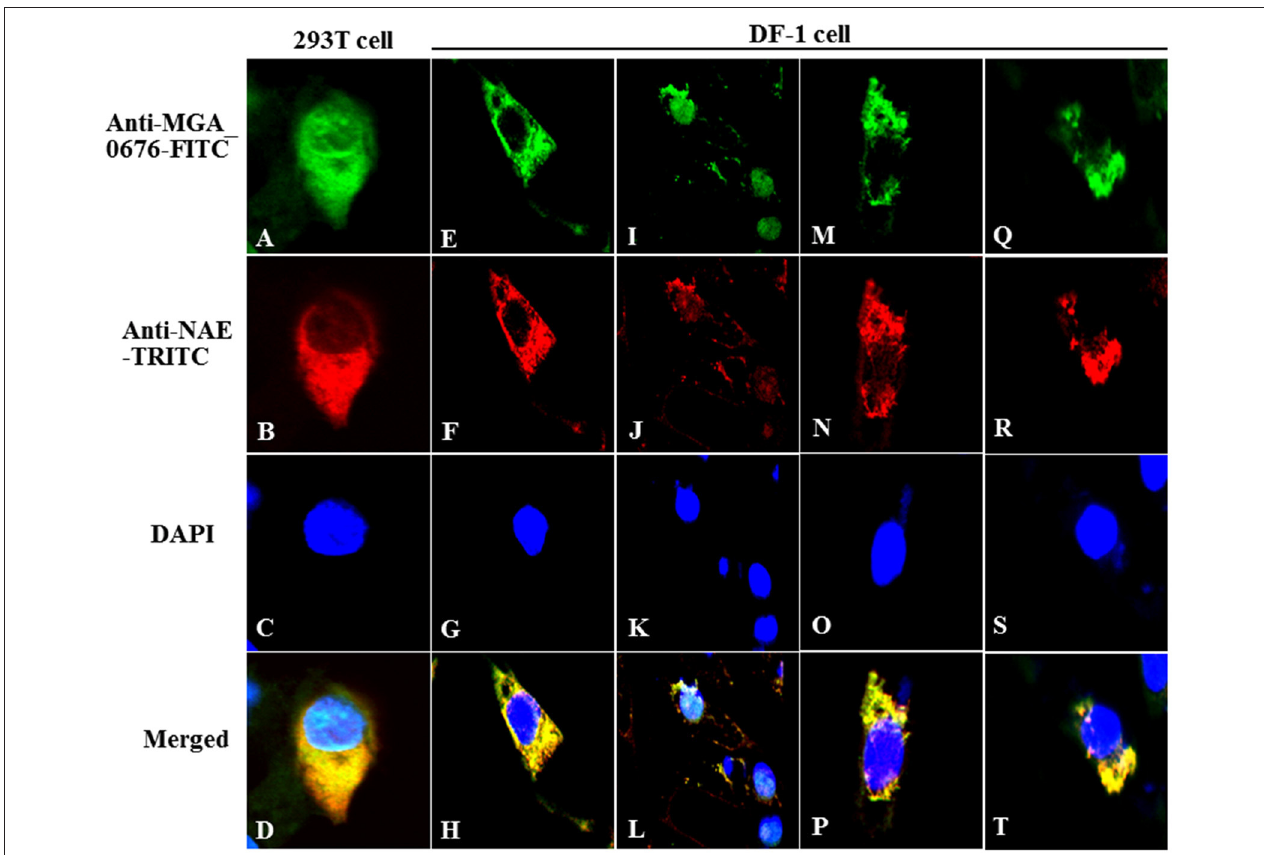
FIGURE 3 | Co-localization of MGA_0676 with NAE in the perinuclear and nuclear regions of cells. HEK293T cells (A–D) or DF-1 cells (E–G) were co-transfected with pCMV-HA-MGA_0676 and pCMV-Myc-NAE. Twenty-four hours after transfection, cells underwent IFA based on anti-HA or anti-Myc antibodies. MGA_0676 was stained with FITC-conjugated goat anti mouse IgG antibody (green), NAE was stained with rhodamine (TRITC)-conjugated goat anti-rabbit antibody (red), and cell nuclei were counterstained with DAPI (blue). Cell samples were observed with a laser confocal scanning microscope. Co-localization of MGA_0676 with endogenous NA, DF-1 cells were transfected with pCMV-HA-MGA_0676 plasmid (I–L ) or incubated with rMGA_0676 (M–P ). Twenty-four hours after treatment, cells underwent IFA based on anti-HA or anti-NAE antibodies; cell samples were observed with a laser confocal scanning microscope. Co-localization of M. gallisepticum MGA_0676 with endogenous NAE in M. gallisepticum -infected cells (Q–T ). DF-1 cells were infected with M. gallisepticum . Twenty-four hours after treatment, cells underwent IFA based on anti-MGA_0676 or anti-NAE antibodies; IFA and the following results were observed with a laser confocal scanning microscope. Scale bar = 10 µ m.